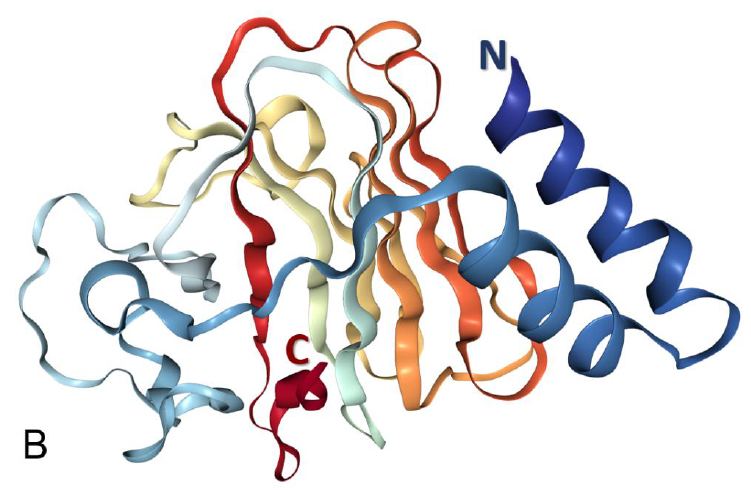
Figure 7. ( A ) Multiple structural alignments of the crystal structures of ectodomains of human BTN3A1 (residues 30–246, PDB ID: 4F80; yellow structure), BTN3A2 (residues 30–239, PDB ID: 4F8Q; blue structure), and BTN3A3 (residues 30–246, PDB ID: 4F8T; red structure). Structures were aligned using the MultiProt tool [118]. ( B ) Crystal structure of the intracellular B30.2/SPRY domain of human BTN3A1 (residues 272–513, PDB ID: 5HM7).